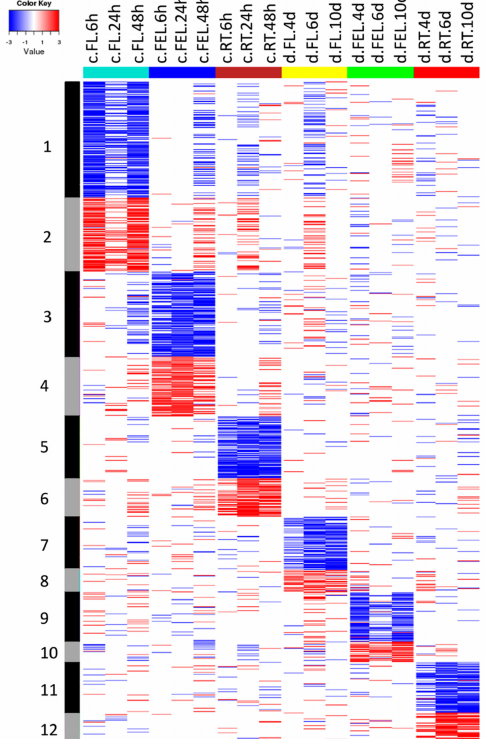
Figure 2. Heatmap of DE genes significantly changed in one tissue responding to cold or drought stress. In total, 12 groups of genes were identified. Blue represents down-regulation, while red represents up-regulation. Samples were named by combination of stresses (“c” for cold, and “d” for drought), tissues, and time points. For examples, c.FL.6h represents sample from FL under cold treatment for 6 h, while d.FL.4d represents sample from FL under drought treatment for 4